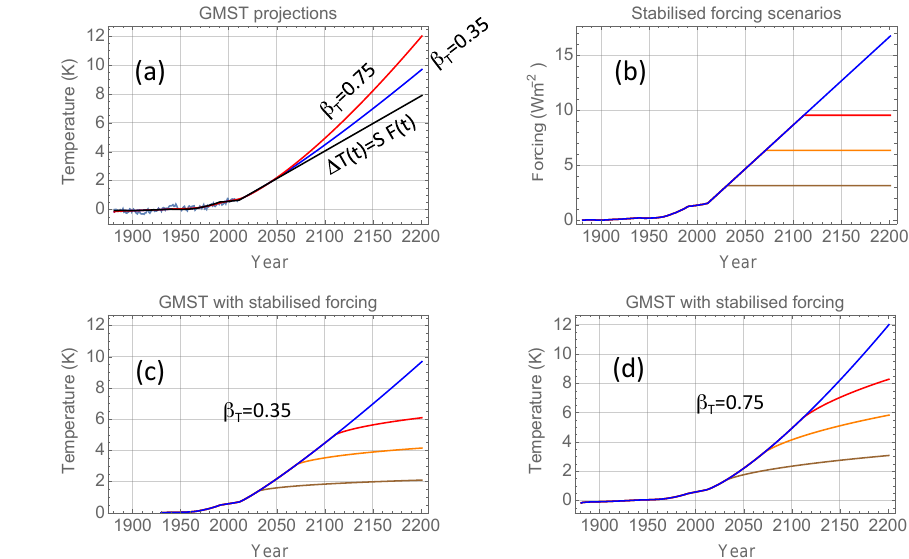
Figure 1. Panel (a) : light blue curve is the instrumental GMST for 1880–2010AD. Black curve is the instantaneous response to the linearly extrapolated forcing scenario shown in panel (b) . Blue curve is the response according to the model Eq. (2) with β T 0 . 35, and the red curve = is the response with β T 0 . 75. Panel (b) : the straight sloping line is a linearly projected forcing to 2200 AD with the same mean growth = rate as the RCP8.5 scenario in the period 2010–2100AD. The horizontal line is the stabilisation of this forcing in 2030AD, the horizontal orange line in 2070AD, and the red horizontal line in 2110AD. Panel (c) : GMST responses to the forcing scenarios in (b) with β T 0 . 35. = Colours correspond to those in (b) . Panel (d) : same as in (c) but with β T 0 . =